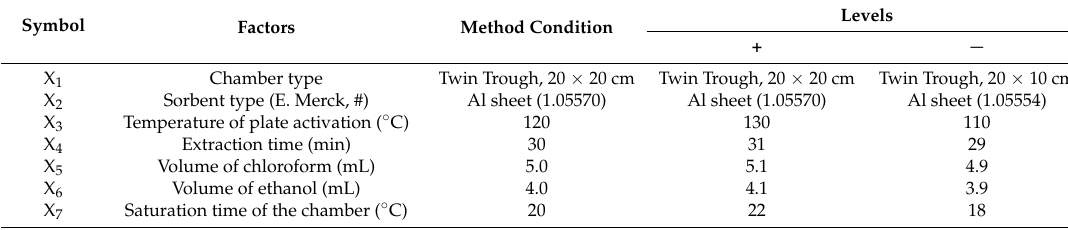
Table 3. The factors and their levels investigated in robustness